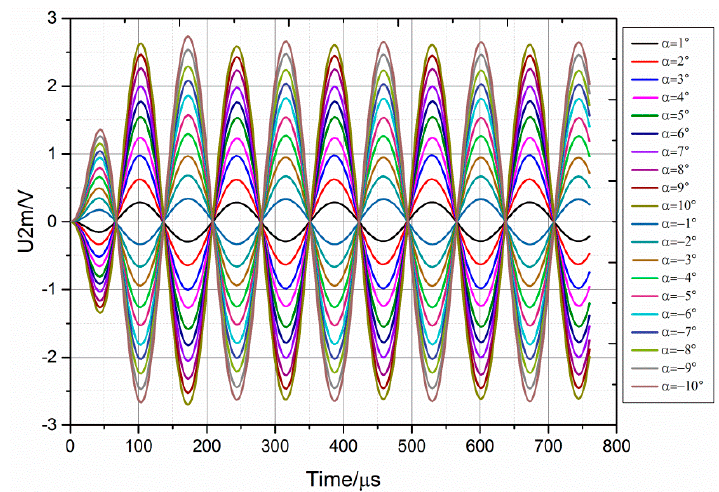
Figure 6. The electric circuit.